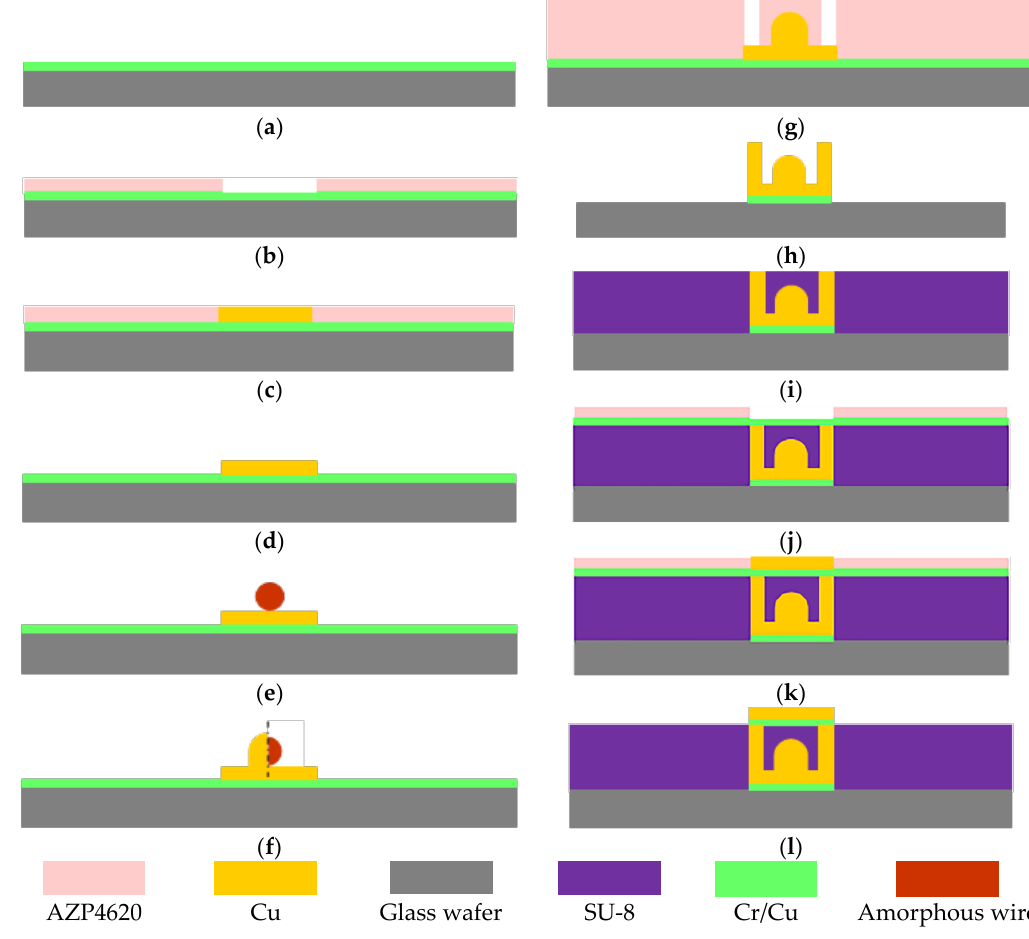
Figure 5. Fabrication process flow of amorphous wire GMI (Giant magneto-impedance) magnetic sensor. (a) Sputtering a Cr/Cu seed layer on the front side of the glass wafer. (b) Spin coating AZP4620 photoresist, then exposing to form the pattern of the bottom lines of the coil. (c) Electroplating copper to form the bottom lines of the coil. (d) Removing the photoresist. (e) Fixing the amorphous wire above the bottom lines of the coil. (f) Electroplating copper at both ends of the amorphous wire. (g) Spin coating AZP4620 photoresist, drying, exposing and developing to form the pattern of the pillars of the coil. (h) Electroplating copper to form the pillars of the coil. (i) Spin coating SU-8 negative photoresist, grinding and polishing to expose the micro Cu pillars. (j) Spin coating AZP4620 photoresist to form the pattern of the upper layer of the coil. (k) Electroplating copper in the pattern to form the upper layer of the coil. (l) Removing the photoresist, etching the seed layer.